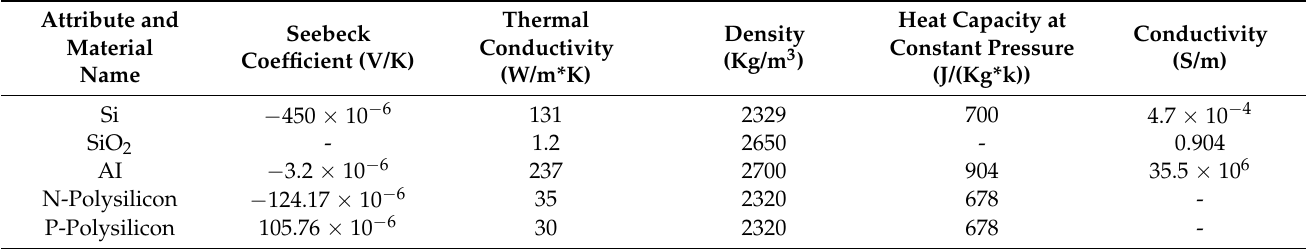
Table 2. Material parameters of COMSOL simulation.